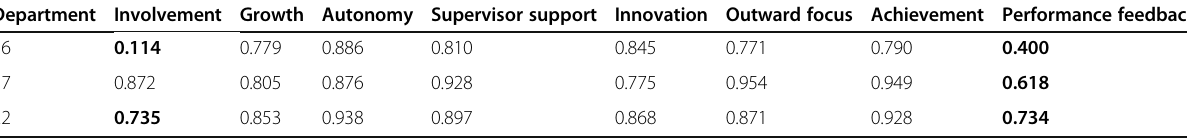
Table 7 r wg(J) results for high-response-rate departments. r wg(J) values below the 0.75 threshold are bolded Department Involvement Growth Autonomy Supervisor support Innovation Outward focus Achievement Performance